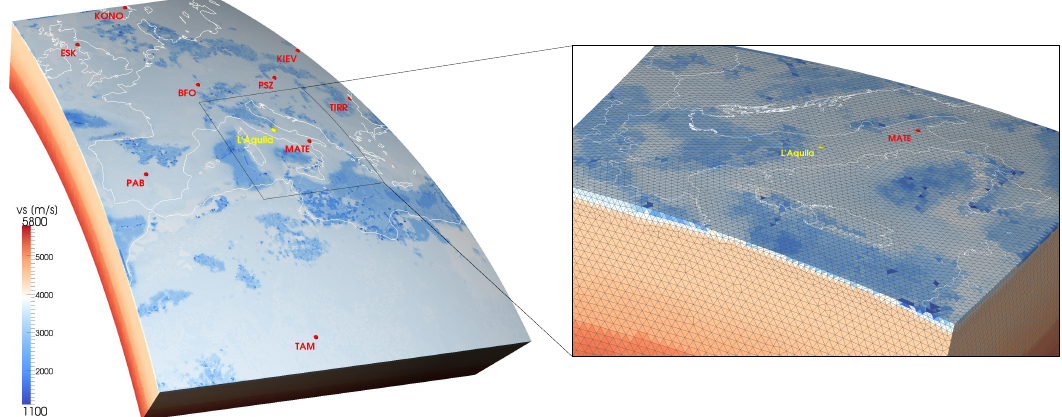
Fig. 5. European model composed of the 3-D EPcrust model of Molinari and Morelli (2011) and the 1-D ak135 model of Kennett et al. (1995) (left). The computational domain is subdivided into a mesh of unstructured tetrahedral elements (right). 3-D Topography of the Earth surface and the crust-mantle boundary is respected by the mesh.